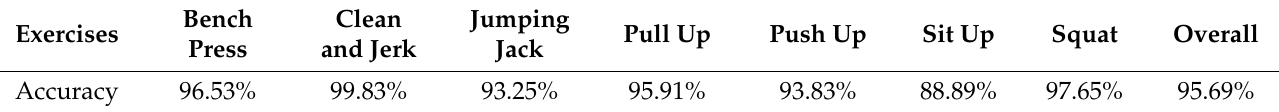
Table 1. Recognition accuracy for each type of